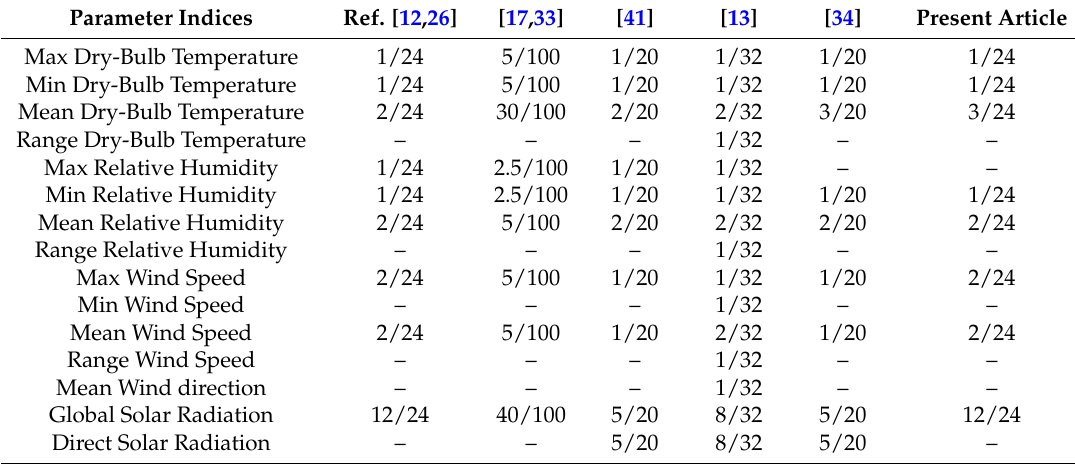
Table 2. Weighting factors for TMY